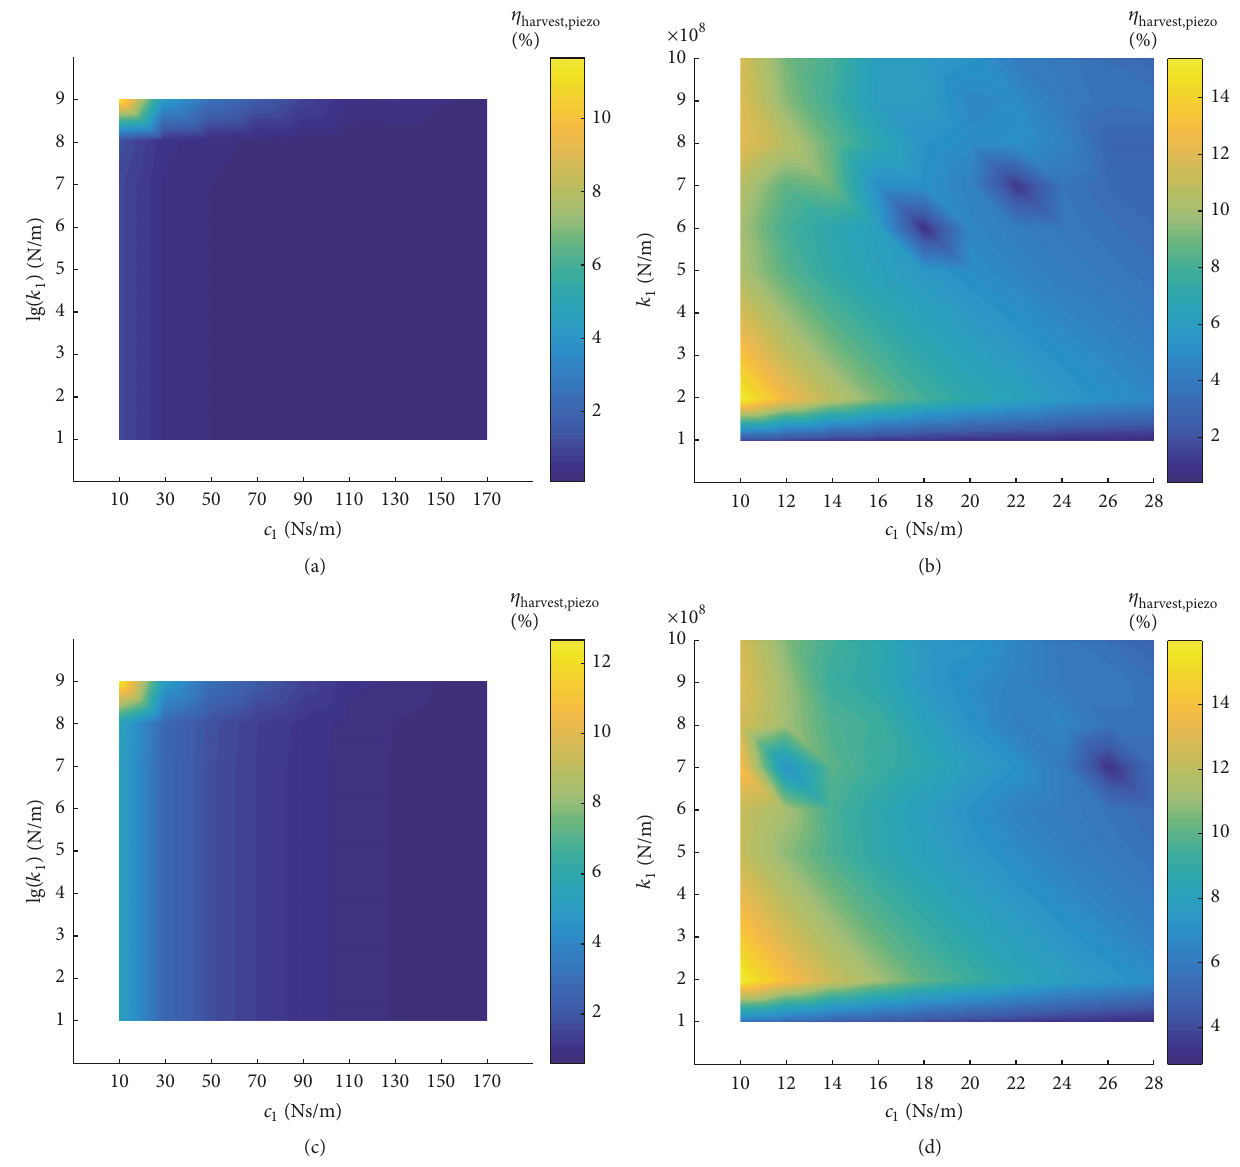
Figure 3: (a) The percentage of energy harvested by the piezoelectric device and (b) its enlargement of configuration 1. (c) The percentage of energy harvested by the piezoelectric device and (d) its enlargement of configuration 2.